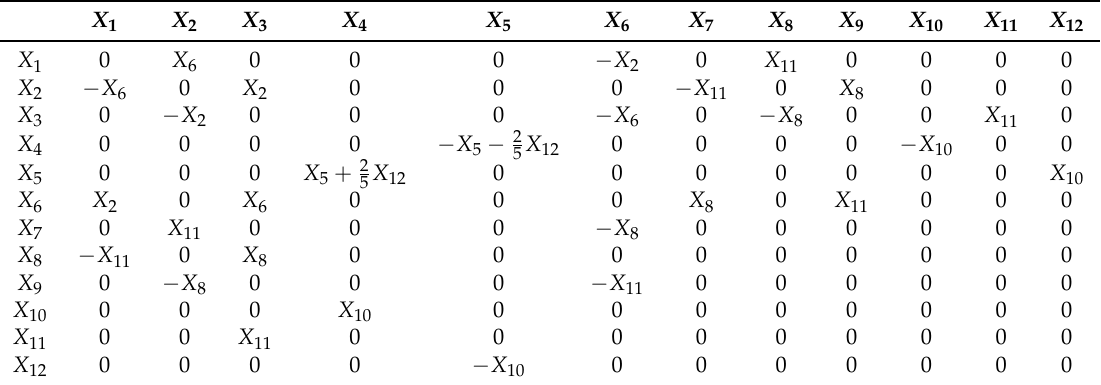
Table 2. Approximate commutator table of approximate symmetries of the perturbed non-linear wave